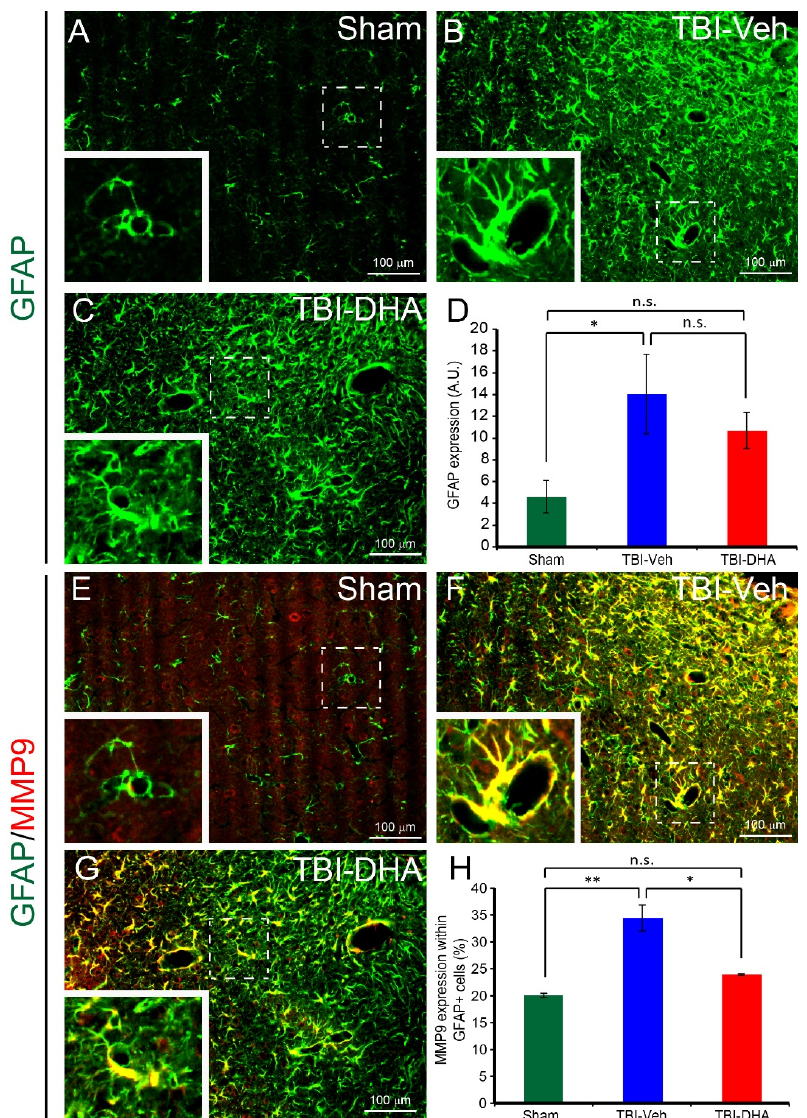
Figure 6. DHA-treated TBI rats exhibited less astrocytic matrix metalloproteinase (MMP9) expression at the peri-injury site than the vehicle-treated TBI rats at 7 days post injury. ( A , E ) In sham-operated rats, some visible glial fibrillary acidic protein (GFAP) expression (green) was observed, with many surrounding blood vessels. MMP9 expression (red) was strongly present in neuronal-like cells. ( B , F ) Vehicle-treated TBI rats exhibited lots of GFAP expression within the brain parenchyma and around blood vessels. Moreover, MMP9 expression (red) was strongly present in neuronal-like cells and within GFAP immunopositive cells. ( C , G ) DHA-treated TBI rats exhibited lots of GFAP expression within the brain parenchyma and around blood vessels. However, MMP9 expression (red) was only strongly present in neuronal-like cells and less within GFAP immunopositive cells. ( D , H ) Analysis of GFAP expression or MMP9 within GFAP immunopositive cells at the pericontusional site revealed a significantly reduced loss of astrocytic MMP9 expression in DHA-treated rats (red, n = 6) compared vehicle-treated TBI rats (blue, n = 6) at 7 days post injury. astrocytic MMP9 expression in sham- operated rats (green, n = 4) was significantly lower than in vehicle-treated TBI rats. The * and ** indicate p < 0.05 and p < 0.01, respectively.